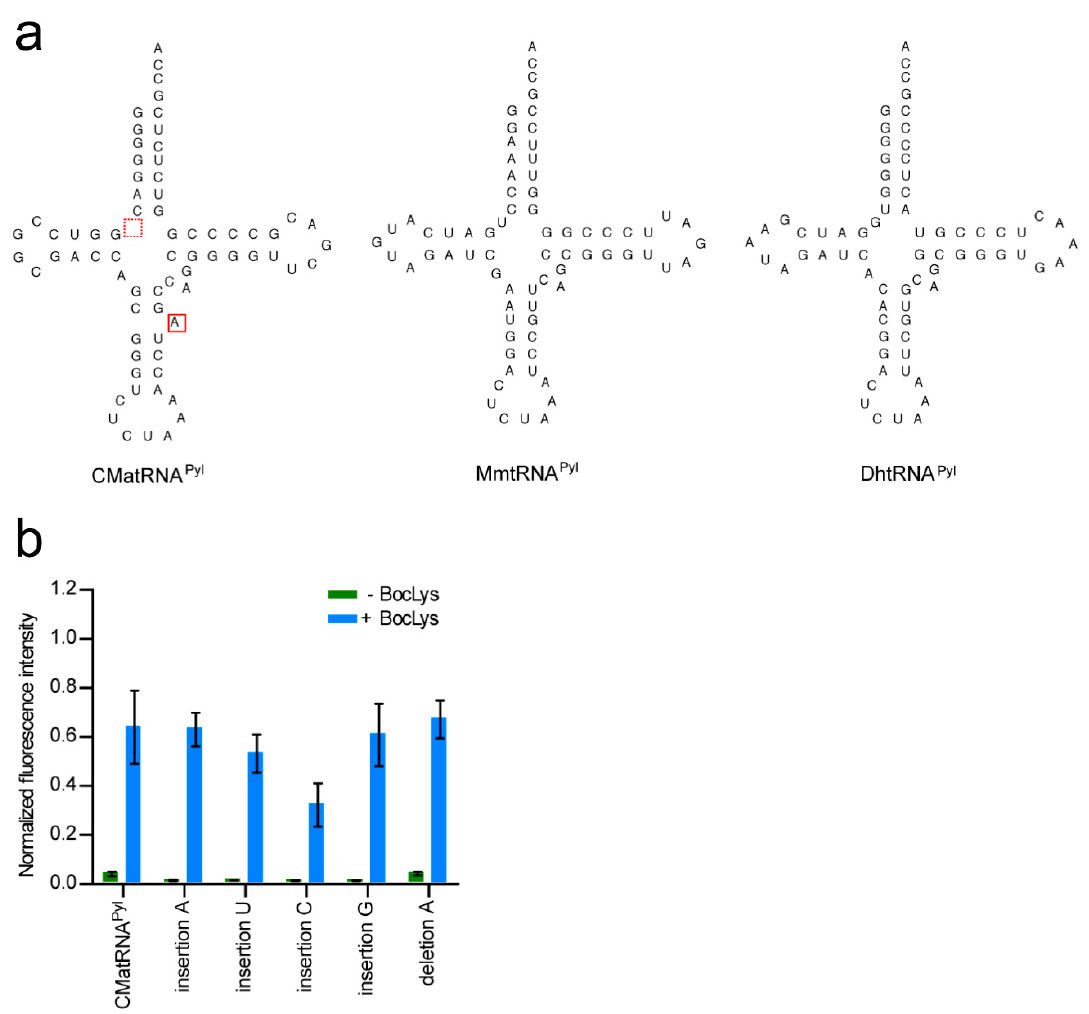
Figure 3. Cell-free UAG translation. The fluorescence intensity of the reaction mixture containing the indicated pair of PylRS and tRNA Pyl was measured at 485 nm with five-minute intervals.